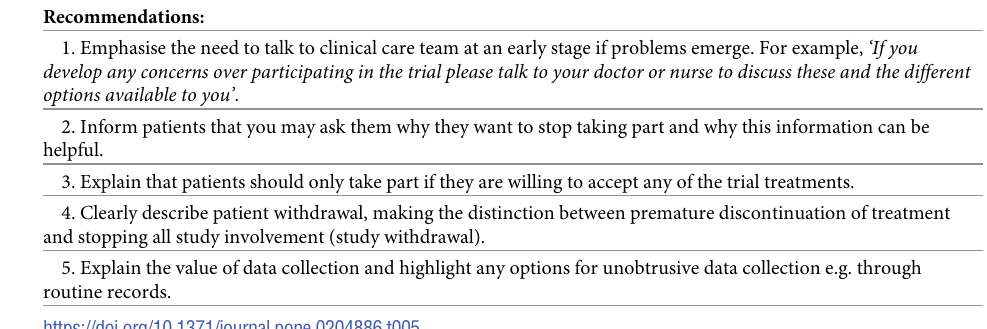
Table 5. Recommendations for retention content within